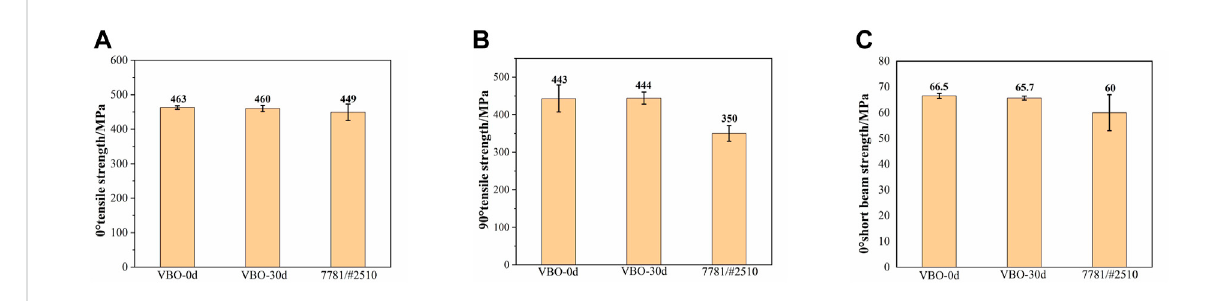
FIGURE 15 The comparison of the optimized composites and Toray ’ s 7781/#2510 composites ’ vacuum bag molding mechanical properties (A) 0 ° tensile properties; (B) 90 ° tensile properties; (C) 0 ° short beam properties.